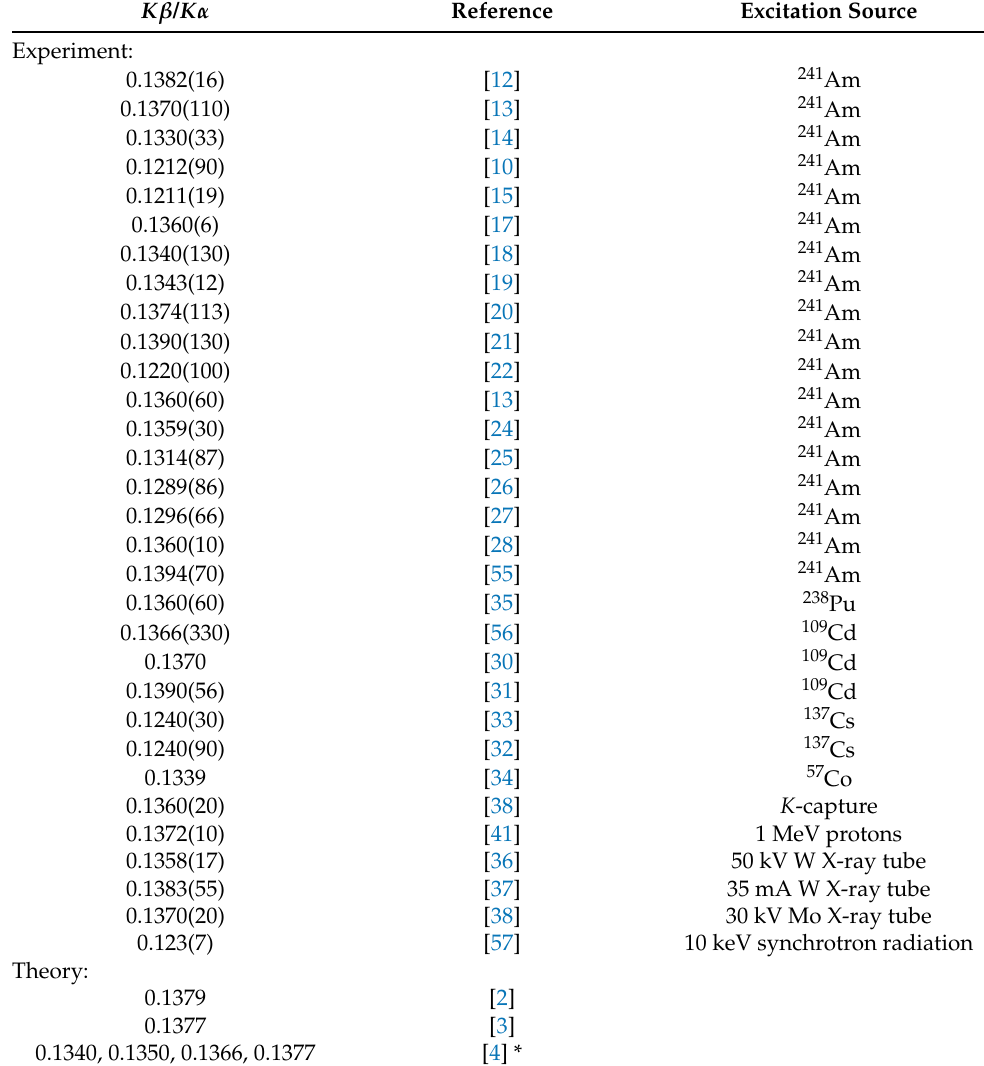
Figure 6. K β / K α intensity ratio arising from the primary X-ray simulated with FLUKA, calculated for forward output flux in 1 µm sample. Table 4. K β / K α intensity ratio for copper taken from the